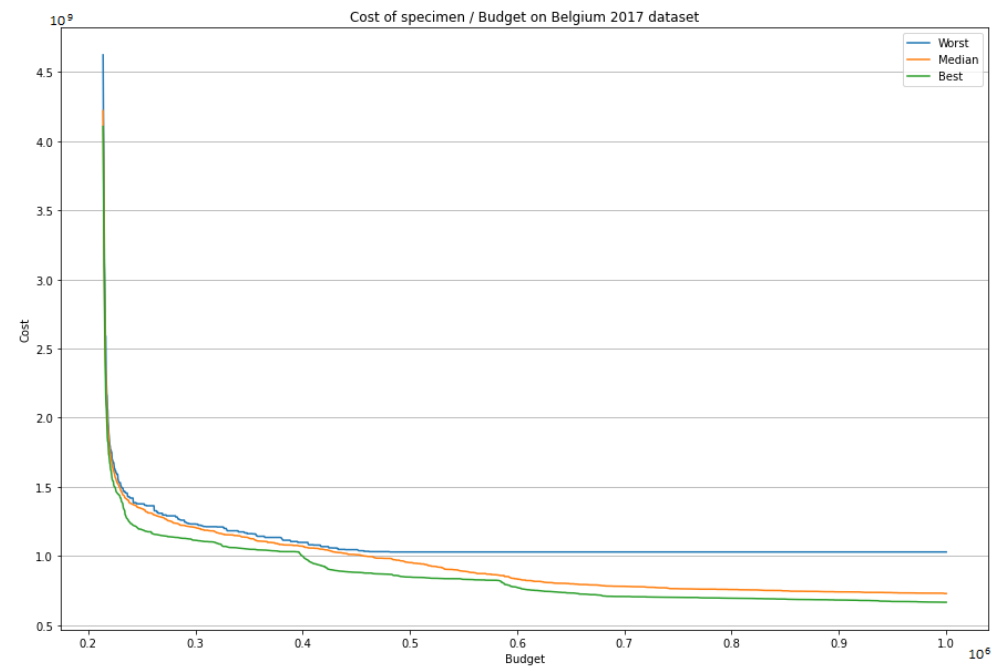
Figure 16. Progress of population of the best run on Belgium 2017